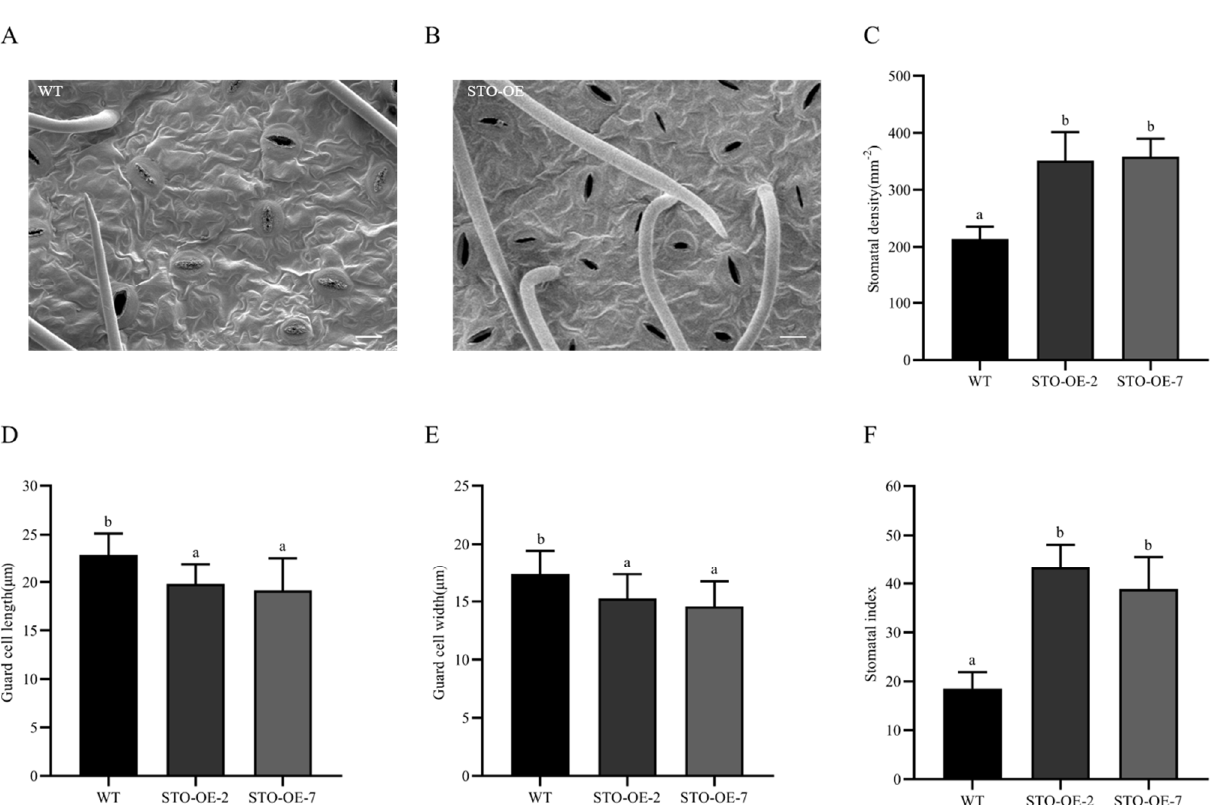
Figure 4. Stomatal density, size, and stomatal index in STO-OE and WT poplar. ( A ) Abaxial leaf epidermis of WT lines. ( B ) Abaxial leaf epidermis of STO-OE lines. ( C ) Stomatal density of STO-OE and WT lines. ( D ) Guard cell length of STO-OE and WT lines. ( E ) Guard cell width of STO-OE and WT lines. ( F ) Stomatal index of STO-OE and WT lines. Error bars are indicated by the SD of five biological replicates. p < 0.05 was considered significantly different and is shown by different letters. Bars = 20 μ m.